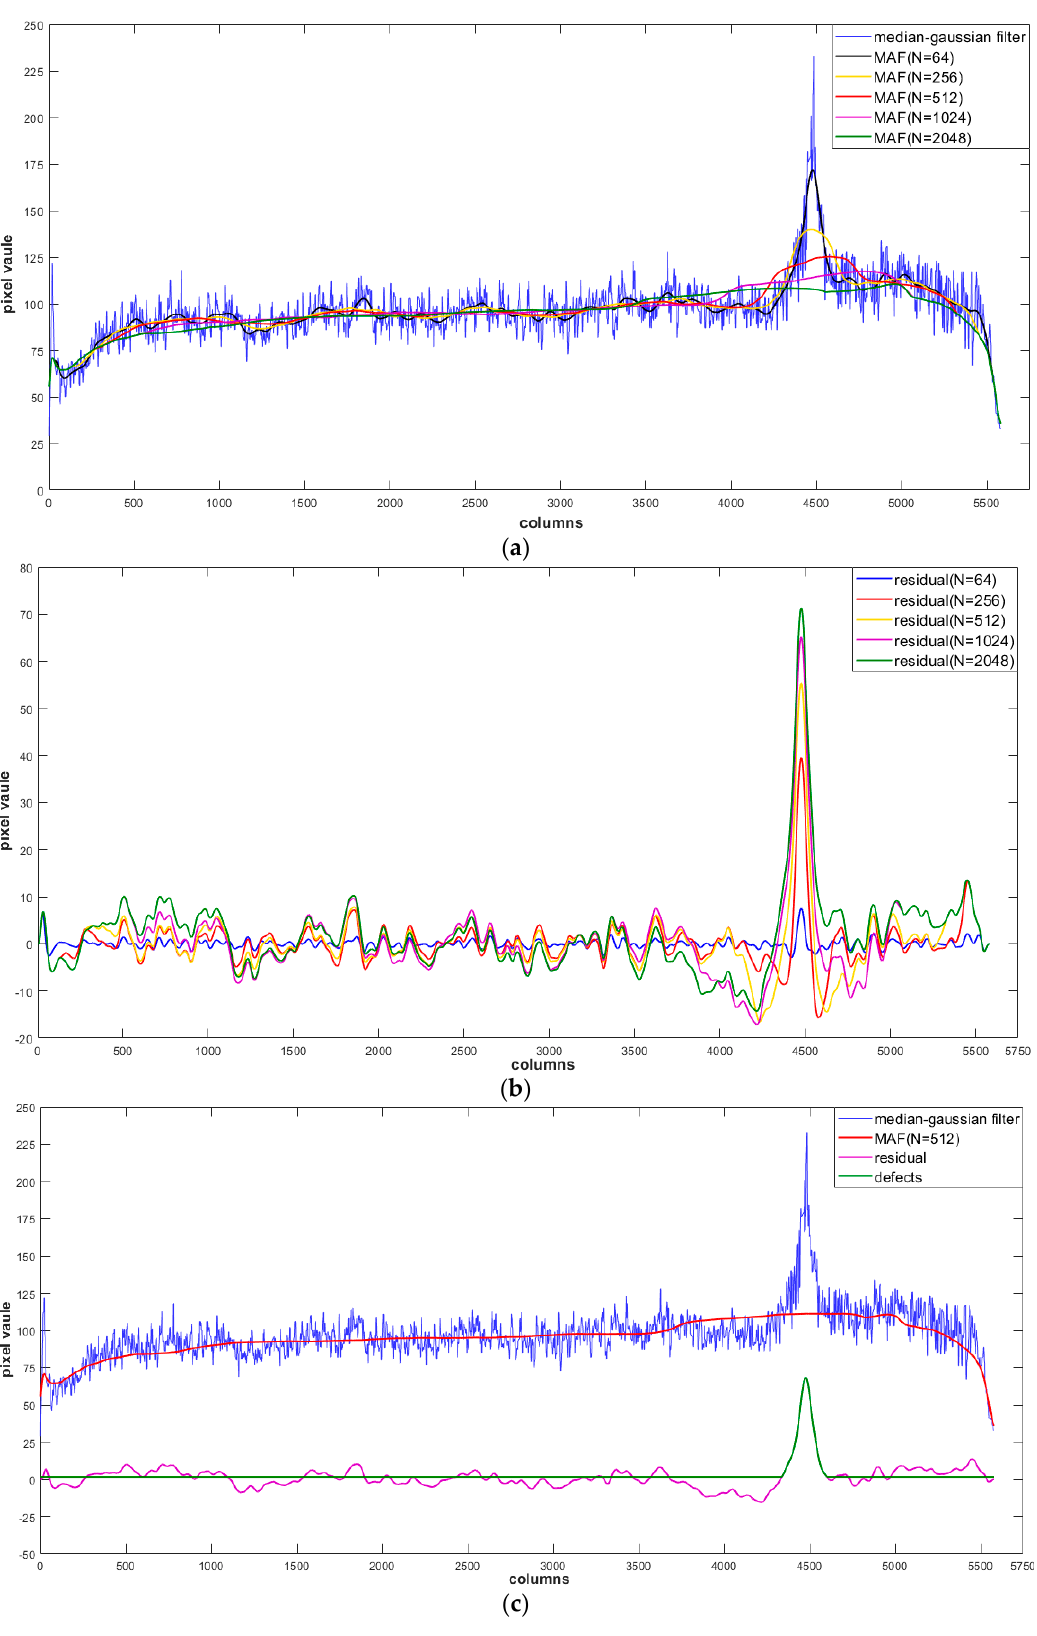
Figure 8. Results of moving average filtering (MAF). ( a ) Result of MAF curve plots with different numbers of samples; ( b ) Result of residuals with different numbers of samples; ( c ) Result of defects extraction when MAF has 512 samples ( N = 512 ).